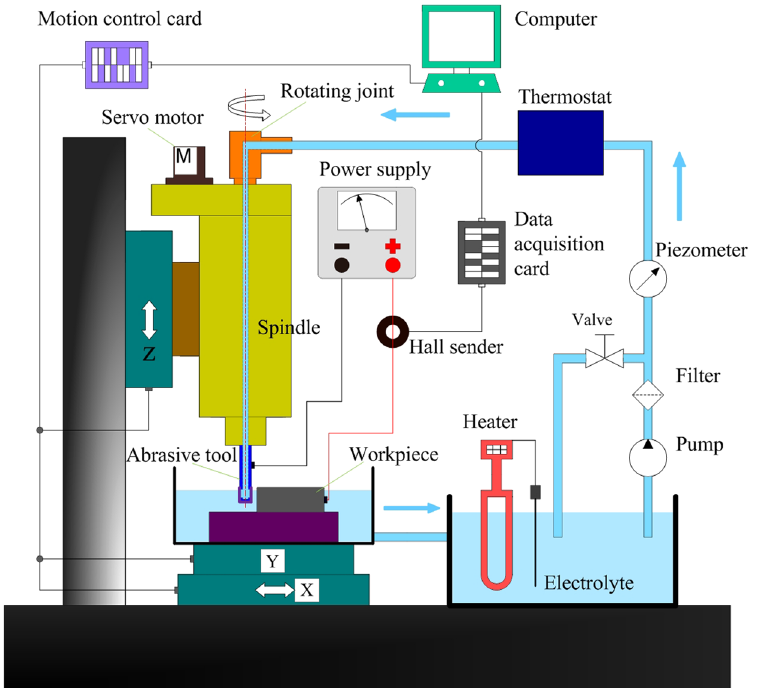
Figure 5. Schematic diagram of the machining